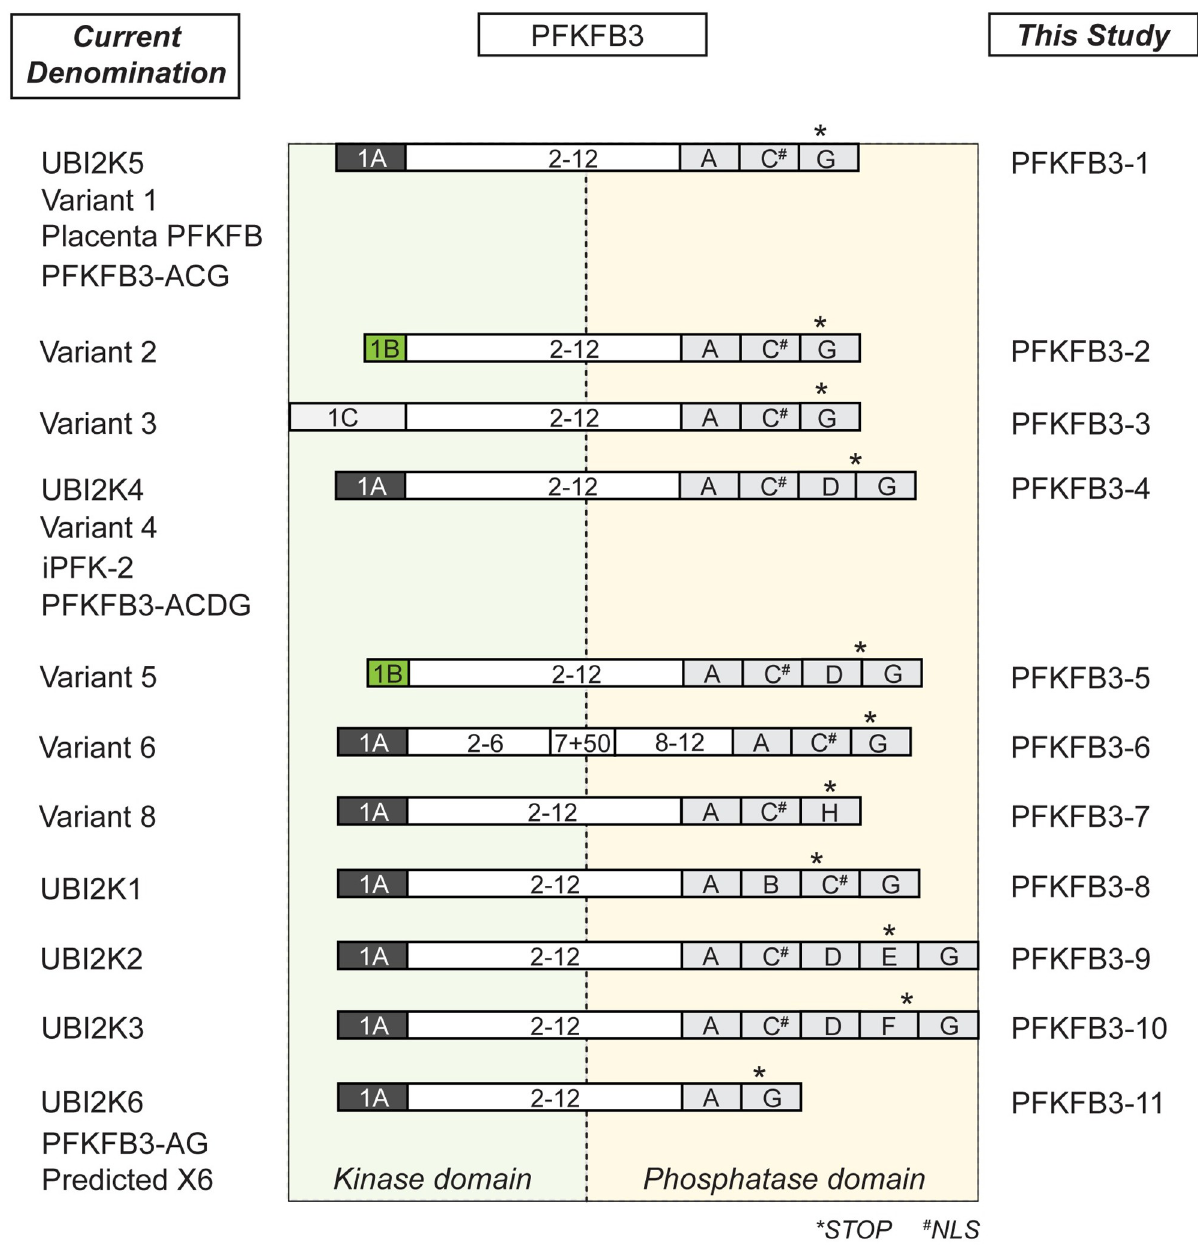
Fig 1. Schematic illustration of the transcript repertoire generated from the human PFKFB3 gene locus. Scheme based on sequence analyses carried out using Basic Local Alignment Search Tool (BLAST) and Multalin interface page (multalin.toulouse.inra.fr/multalin). Left panel shows the current denomination of splice variants documented in the literature and NCBI database; right panel indicates the denomination PFKFB3-1-11 used in this study. Conserved exons are depicted as white boxes with numbers except for PFKFB3-6, which contains an additional insert of 50 bp in exon 7. Variable N-terminal and C-terminal exons are colored and indicated by capital letters. � indicates stop codon of each splice variant, # indicates predicted nuclear localization signals (NLS). PFKFB3-1: NM_004566.4 [17, 18, 22–24]; PFKFB3-2: NM_001145443.3; PFKFB3-3: NM_001282630.3; PFKFB3-4: NM_001314063.2 [17, 18, 25]; PFKFB3-5: NM_001323016.2; PFKFB3-6: NM_001323017.2; PFKFB3-7: NM_001363545.2; PFKFB3-8: AJ272438.1 [17]; PFKFB3-9: AJ295747.1 [17]); PFKFB3-10: AJ272439.1; PFKFB3-11: AJ272440.1 [17, 18], XM_005252464.2; Variant 7: NR_1365554.2 represents non-coding RNA and is therefore not